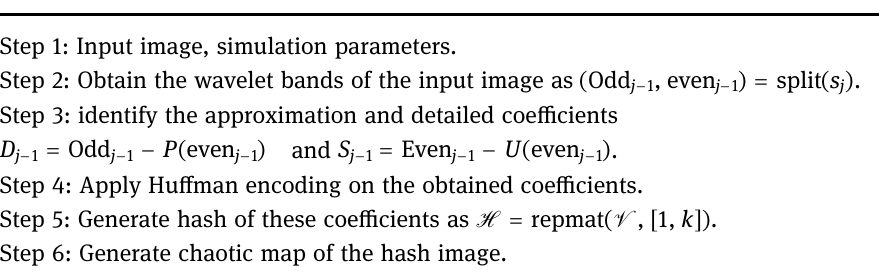
Algorithm 1. Image compression and securing